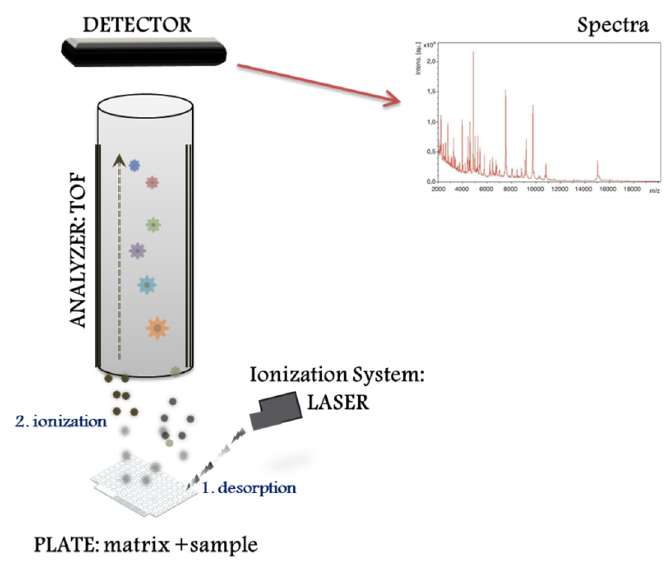
Figure 1. Schema showing the linear mode workflow in a MALDI–TOF MS system.